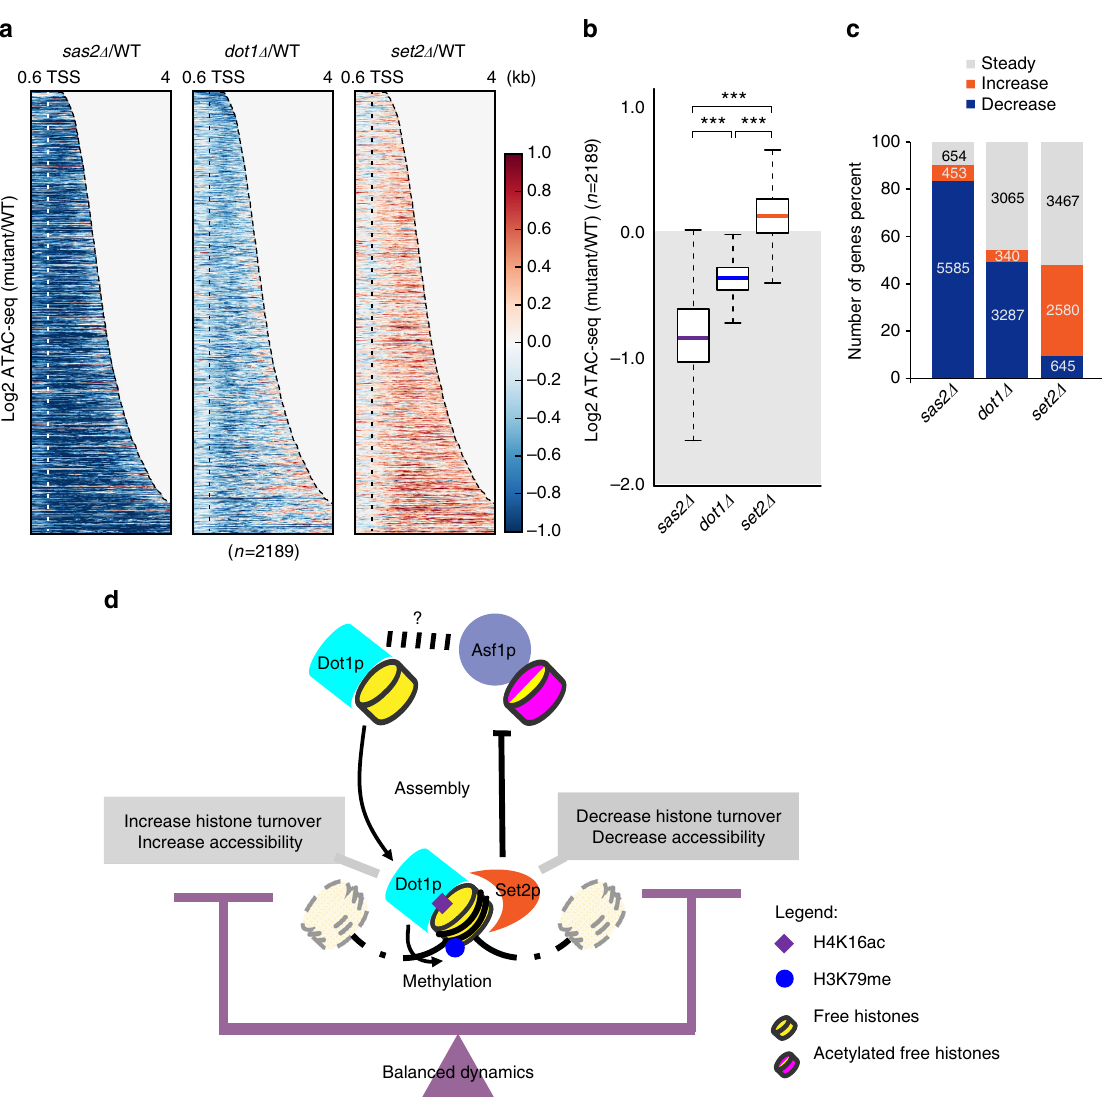
Fig. 6 Dot1p facilitates nucleosome accessibility in the transcribed region of genes. a Heatmap for the log 2 fold change of the ATAC-seq signal in sas2 Δ (left), dot1 Δ (center), and set2 Δ (right) cells versus wild type. Increased accessibility is indicated in red, and decreased accessibility is indicated in blue. Genes were ordered by their accessibility difference in dot1 Δ versus wild-type cells ( n = 2189). Data were obtained from biological duplicates. The y -axis indicates each genes and the x -axis indicates distance from TSS. The genes in heatmap was arranged in order of gene length. The color bar represents value of log 2 mutant compared to wild-type (color red: > 0, color blue: < 0). The dotted lines indicate the TSS. All values were normalized to the read count, and the value of the region exceeding the TES was treated as 0. b A boxplot of ATAC signal log 2 fold changes in mutants over wild type. The value of ATAC signal implies chromatin accessibility. The values of the y -axis indicate log2 fold change level of ATAC-seq value in each sas2 Δ (purple), dot1 Δ (blue), and set2 Δ (orange) mutant over wild-type cells. *** P -value < 0.001, calculated by Wilcoxon and Mann – Whitney tests, and the shadowed box represents negative values. c Stacked percent graph for the difference in accessibility between mutant and wild-type cells. Log 2 fold changes between mutants ( sas2 Δ , dot1 Δ , and set2 Δ ) and wild-type on transcribed regions were analyzed using Bwtool and the following classi fi cation criteria: increased (orange), log change > 0.2; decrease (blue), log 2 fold change < − 0.2; steady (gray), − 0.2 < log 2 fold change < 0.2. d The proposed model. Dot1p binds the nucleosome with the support of H4K16ac (purple diamond), and increases histone turnover and accessibility via its inherent histone chaperone activity (nucleosome binding). Conversely, Set2 acts to decrease histone turnover and accessibility, thereby balancing nucleosome dynamics. Dot1p methylates H3K79 by nucleosome binding (blue circle), but this activity is independent of its involvement in balancing nucleosome